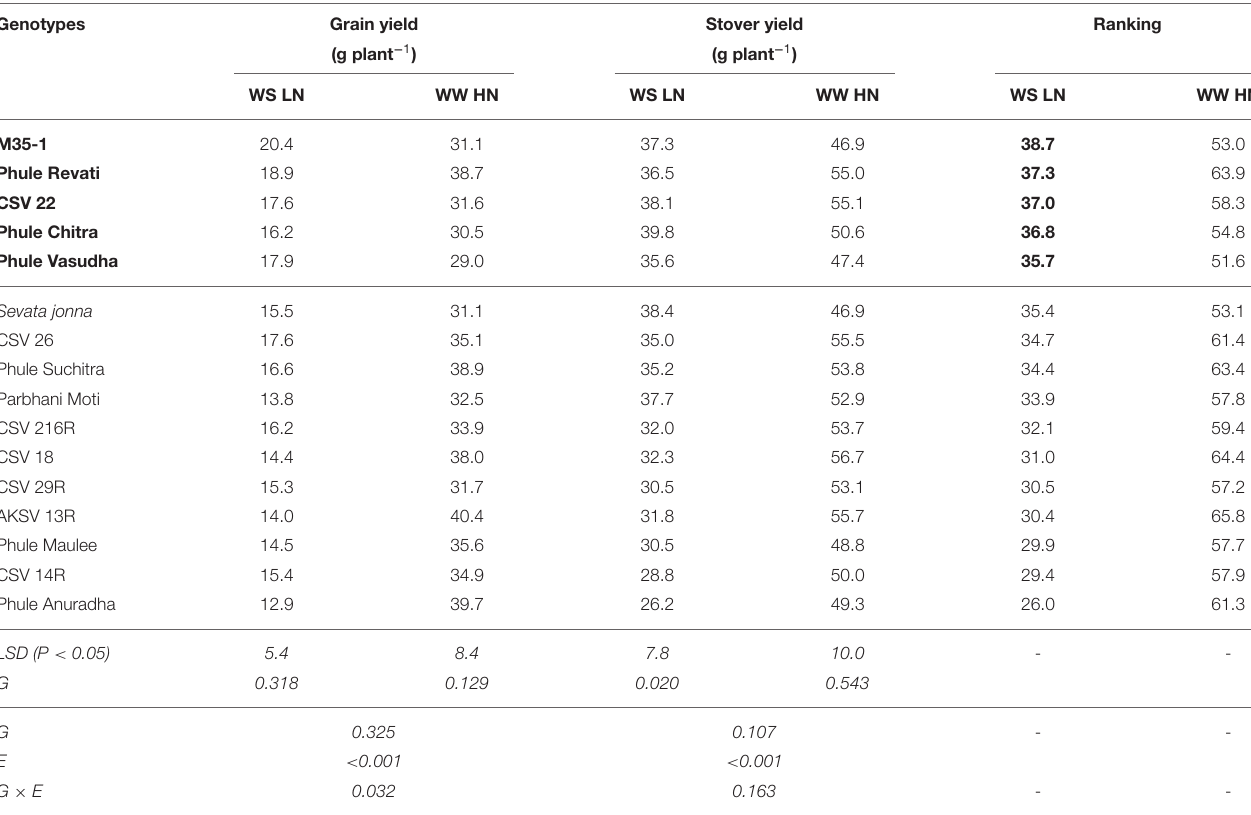
TABLE 1 | Selection of sorghum varieties based on grain and stover yield (g plant − 1 ) tested under low-input (water stressed with low nitrogen input, WSLN) and high-input (well-watered with high nitrogen, WWHN) conditions in postrainy ( rabi) trial of 2017–18. Genotypes Grain yield Stover yield